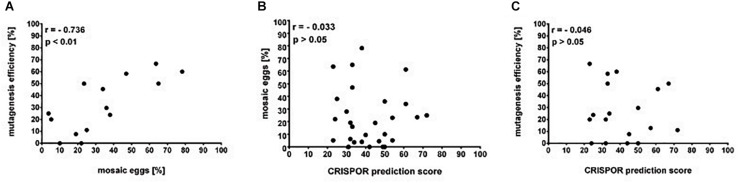
Guide RNAs on-target efficiency. (A) Mutagenesis efficiency (% of G0 parents producing F1 heterozygotes of the total fertile G0 parents) is positively correlated to the percentage of egg mosaics from the in vivo efficiency assay (Spearman correlation p < 0.01). (B) Percentage of eggs mosaicism and (C) mutagenesis efficiency is not correlated to the in silico prediction by the CRISPOR software (Spearman correlation p > 0.05).